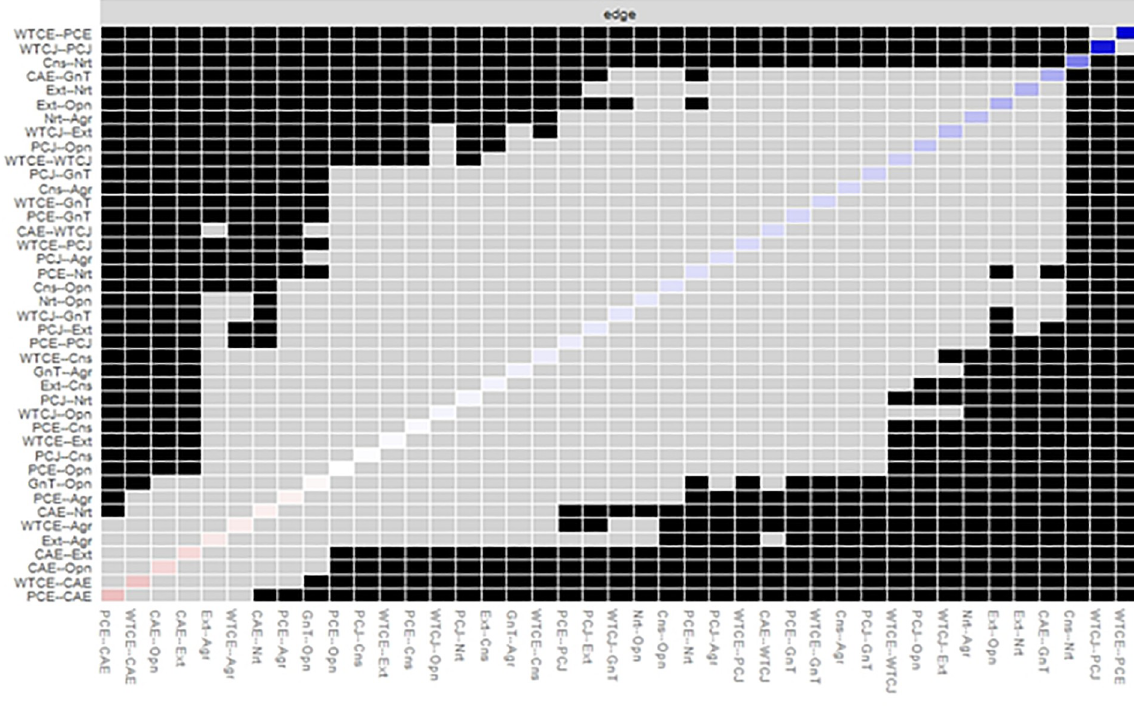
Fig 5. Bootstrapped differences ( α = 0.05) between edge weights that were non-zero in the estimated network. Gray boxes indicate edges that do not differ significantly from one another. Black boxes indicate edges that differ significantly from one another. Colored boxes correspond to the colors of the edges in the estimated network (Not shown in this paper). The abbreviations are the same as Fig 1.